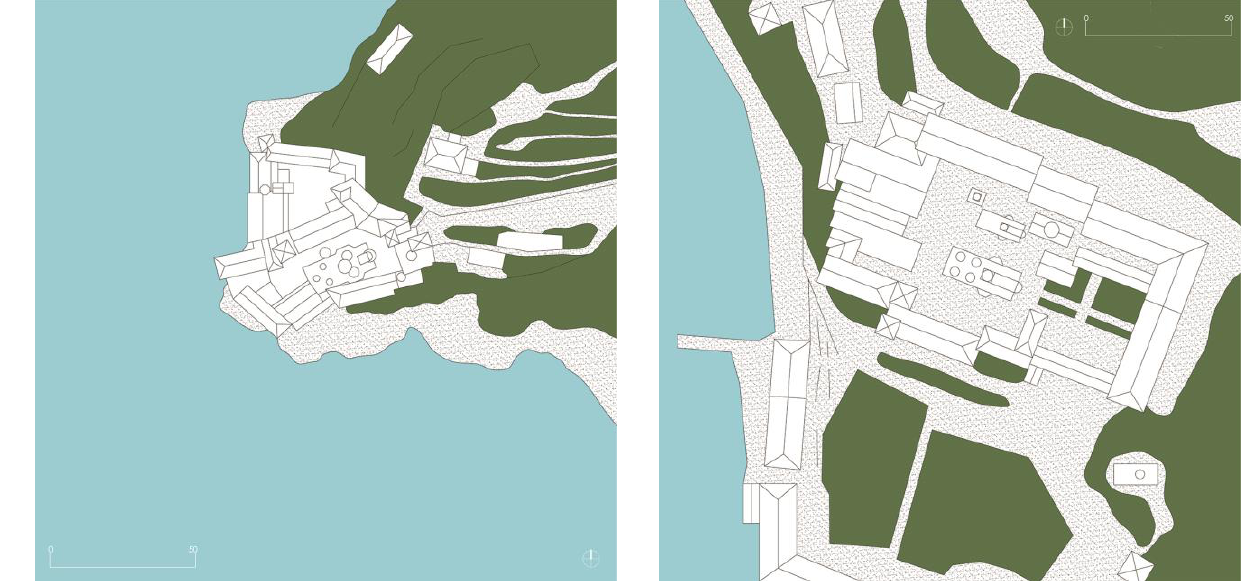
Figure 21 . The Monastery of St. Gregory. General plan.